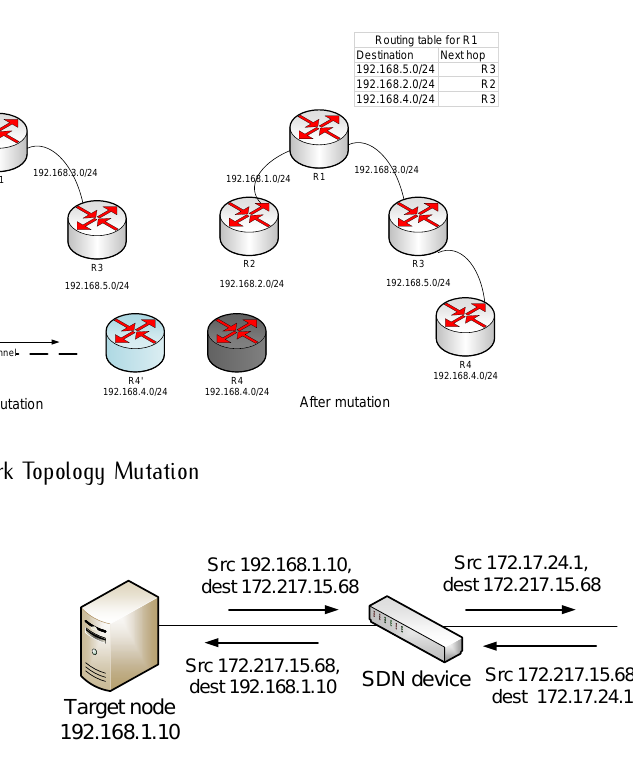
Figure 5. Network Traffic